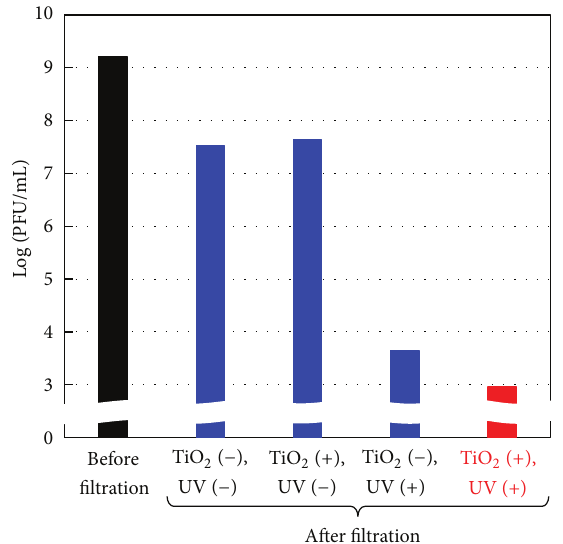
Figure 5: The Q 𝛽 reduction test result with the porous a-silica glass tube without TiO 2 layer under no UV-C irradiation (TiO 2 ( − ), UV( − )), the porous TiO 2 -coated a-silica glass tube under no UV-C irradiation (TiO 2 (+), UV( − )), the porous a-silica glass tube without TiO 2 layer under UV-C irradiation (TiO 2 ( − ), UV(+)), and the porous TiO 2 -coated a-silica glass tube under UV-C irradiation (TiO 2 (+),